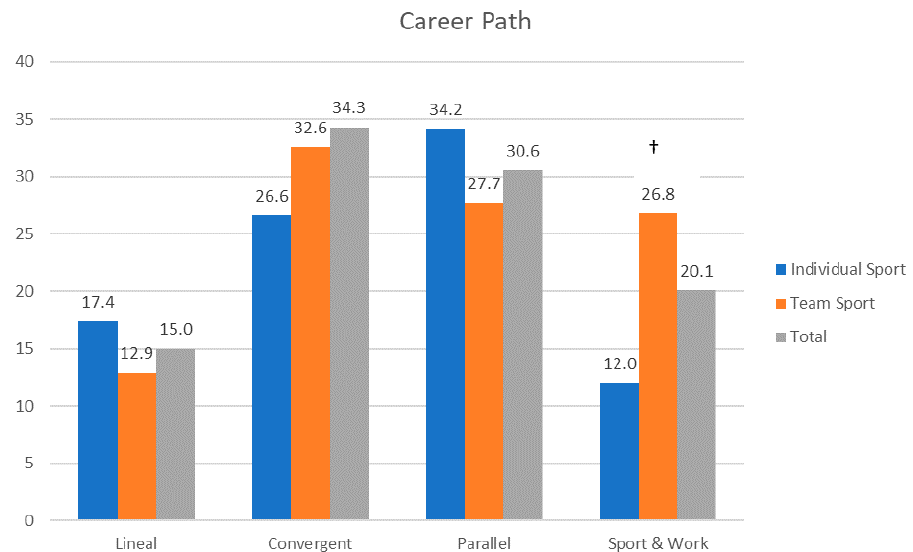
Figure 1. Athletes’ career paths regarding the type of sport in percent (note: † adjusted residuals above 3).